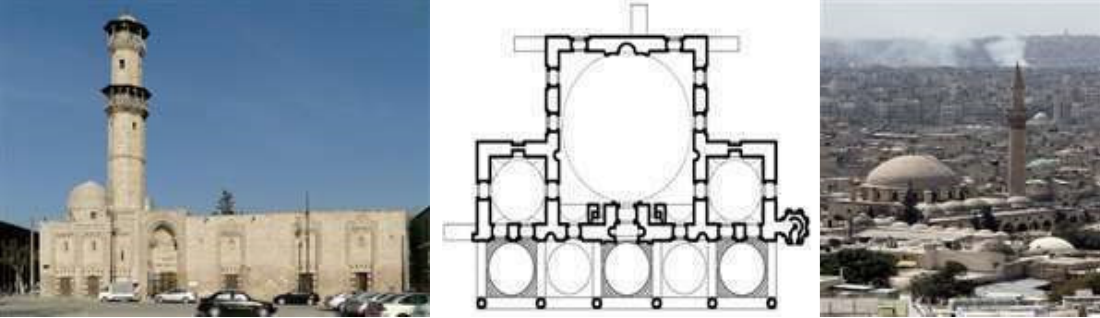
Fig, 3: a- Al-Aṭroush Mosque, Aleppo (Gagnon, 2010), b- Earring layout (Hassan and Mustafa, 2013) c- Ādiliyya mosque, Aleppo (Guillaume, Fig, 3: a‐ Al‐Aṭroush Mosque, Aleppo (Gagnon, 2010), b‐ Earring layout (H assan and Mustafa , 2013) c‐ Ādiliyya mosque, Aleppo (Guillaume, 2010),